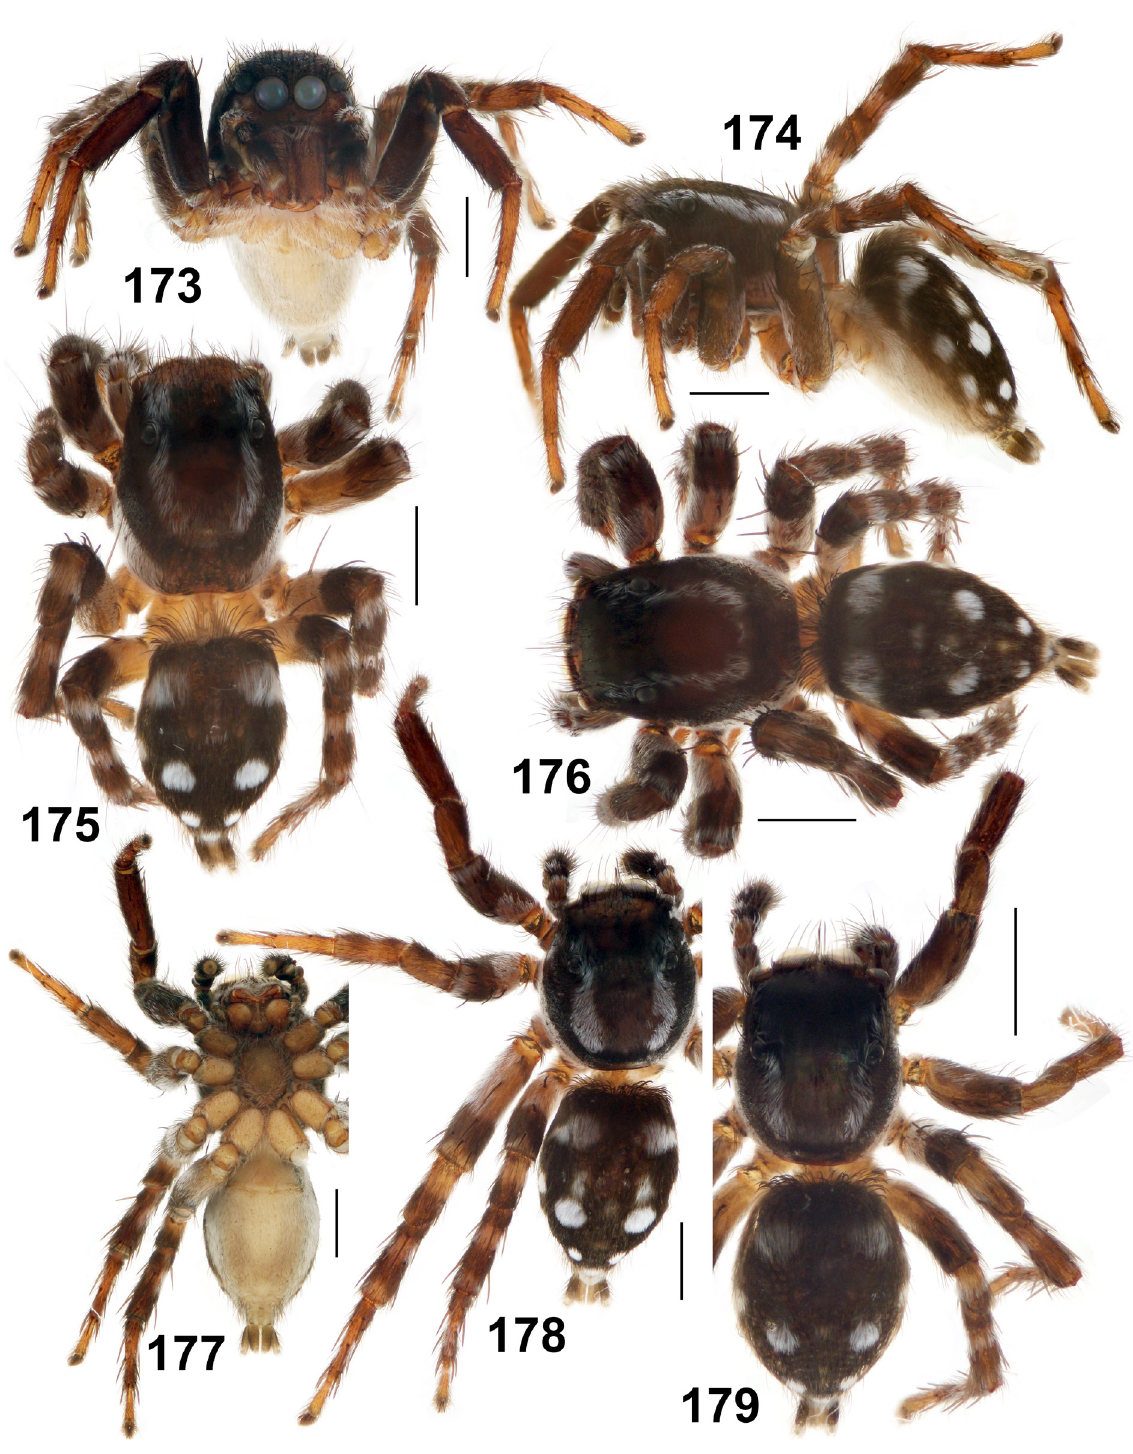
Figs 173–179. Stenaelurillus guttatus (Wesołowska & Cumming, 2002) comb. nov., ♂, from Zambia (Namwala Kafue NP; NCA 2007/573), general appearance. Scale bars: